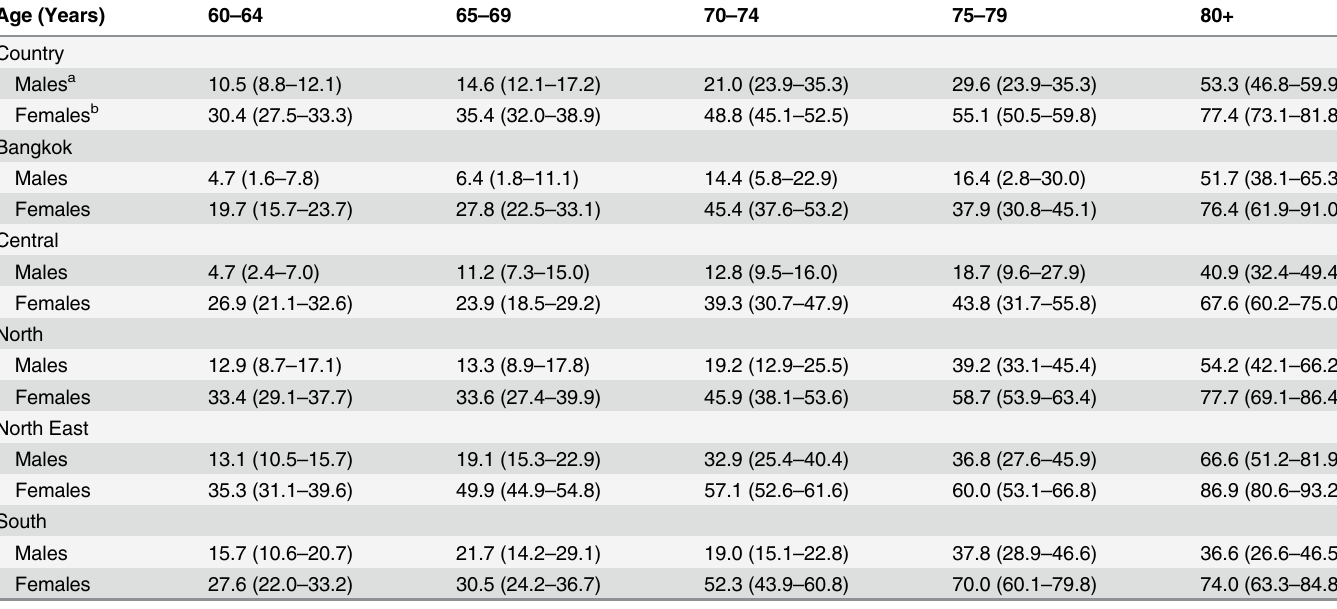
Table 1. Age- and sex- specific prevalence * (in percent) of mobility limitation for Thailand, and the 4 regions and Bangkok, 2009 (95%CIs in